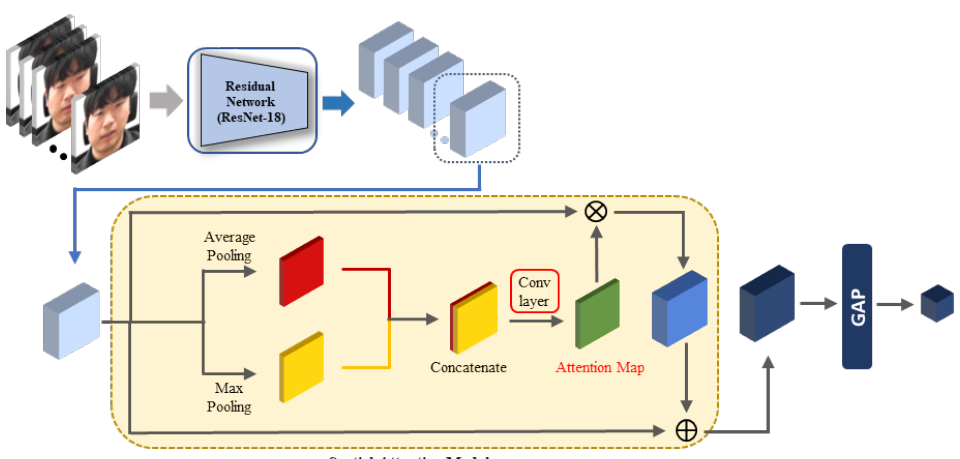
Figure 3. Structure of the spatial attention module. For efficient learning, the multiplication result from the original feature maps and the spatial attention map is added to the original feature maps. GAP: global average